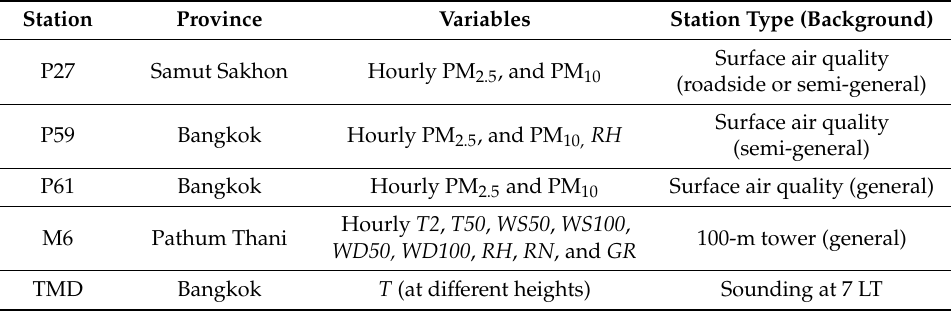
Table 1. Monitoring stations considered in this study.